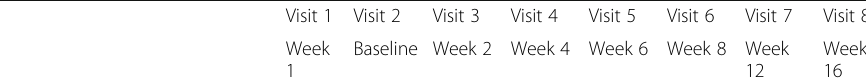
Blood tests (liver function test, renal function test) Blood